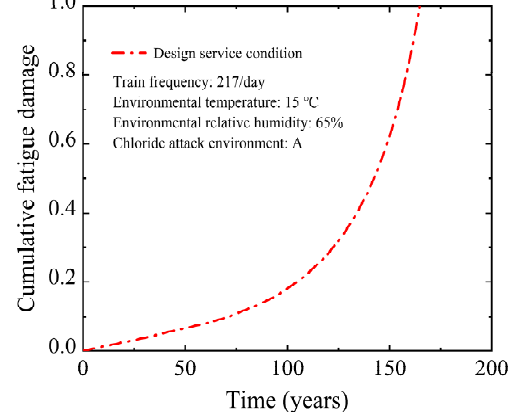
Figure 5. Cumulative fatigue damage of U-shaped beam under design service condition.